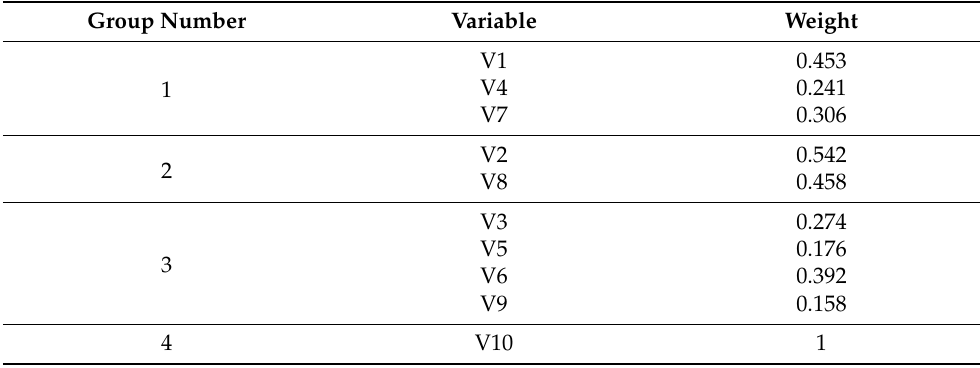
Table 10 lists the weights for variables in four groups. Table 10. Variable